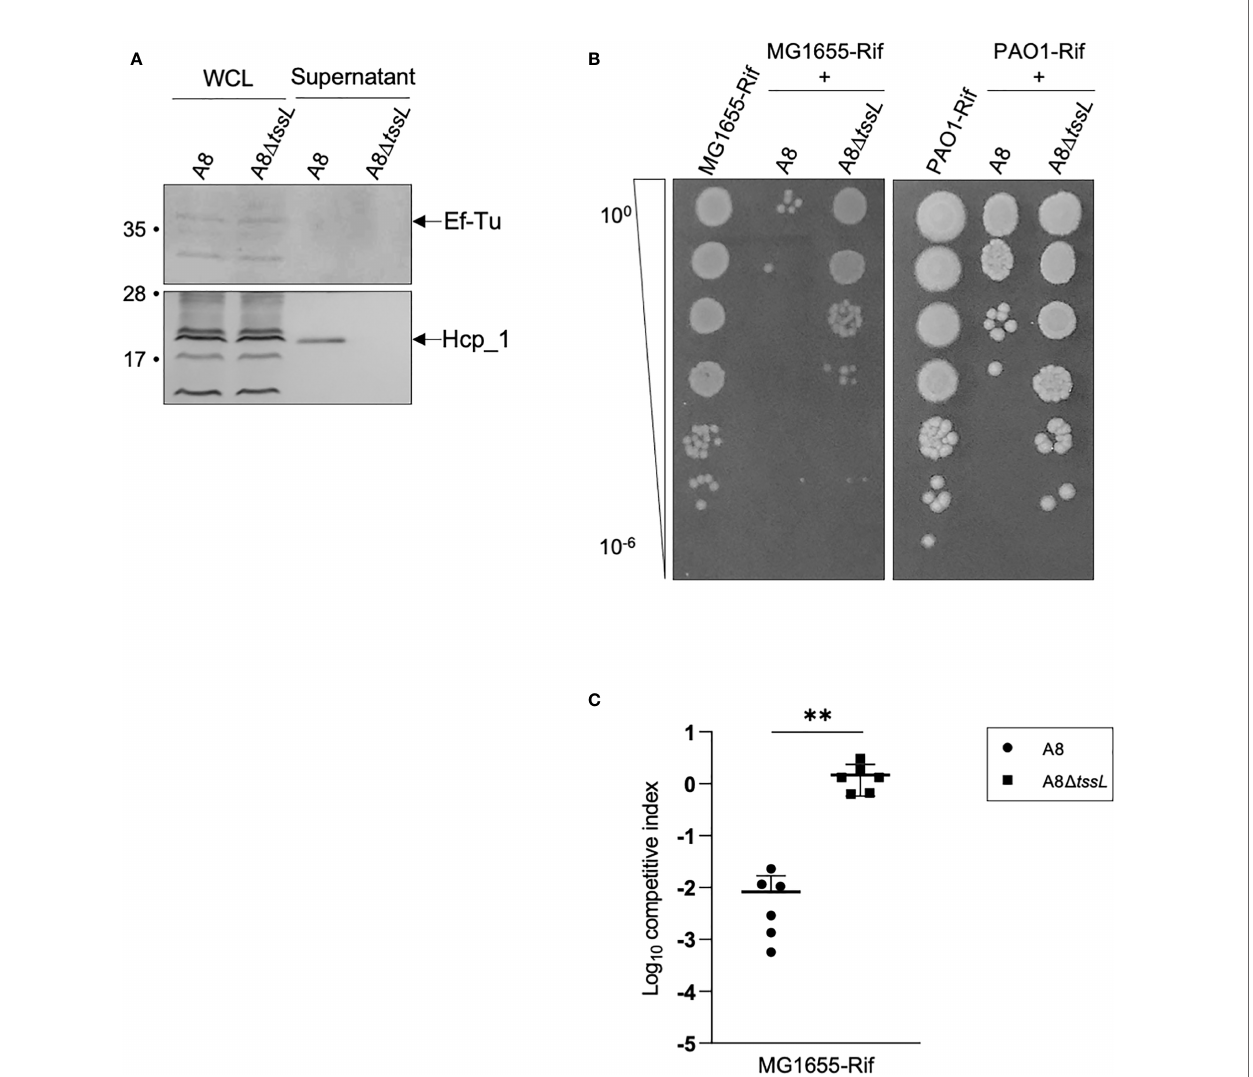
FIGURE 3 | Deletion of tssL affects A8 Hcp secretion as well as its competition against E. coli and PAO1. (A) Immunoblot analysis of fractions containing 0.1 OD unit of whole-cell lysates (WCL) and 2 OD units of culture supernatants (SN) from Achromobacter A8 and A8 D tssL . Ef-Tu was detected as cell lysis control. The position of Hcp and EF-Tu are indicated on the right. Molecular weight markers (in kilodaltons) are indicated on the left. (B) Picture of a representative survival of prey cells (MG1655-Rif or PAO1-Rif) after co-incubation with Achromobacter A8 or A8 D tssL . Prey and attacker were mixed in a 1:10 ratio and incubated 6 h at 28°C on VB agar. Surviving preys are observed after spotting 10-fold serial dilutions of the mix on LB agar containing rifampicin. (C) MG1655-Rif were mixed with Achromobacter A8 or A8 D tssL in a competition assay at 1:10 ratio. Both species were counted before and after 7 h of co-incubation to determine the competitive index (ratio of MG1655-Rif to Achromobacter output divided by the ratio of MG1655-Rif to Achromobacter input). Horizontal bars represent the mean and error bars represent the standard deviation. Statistical signi fi cance was determined by a Student ’ s unpaired t -test (** p =